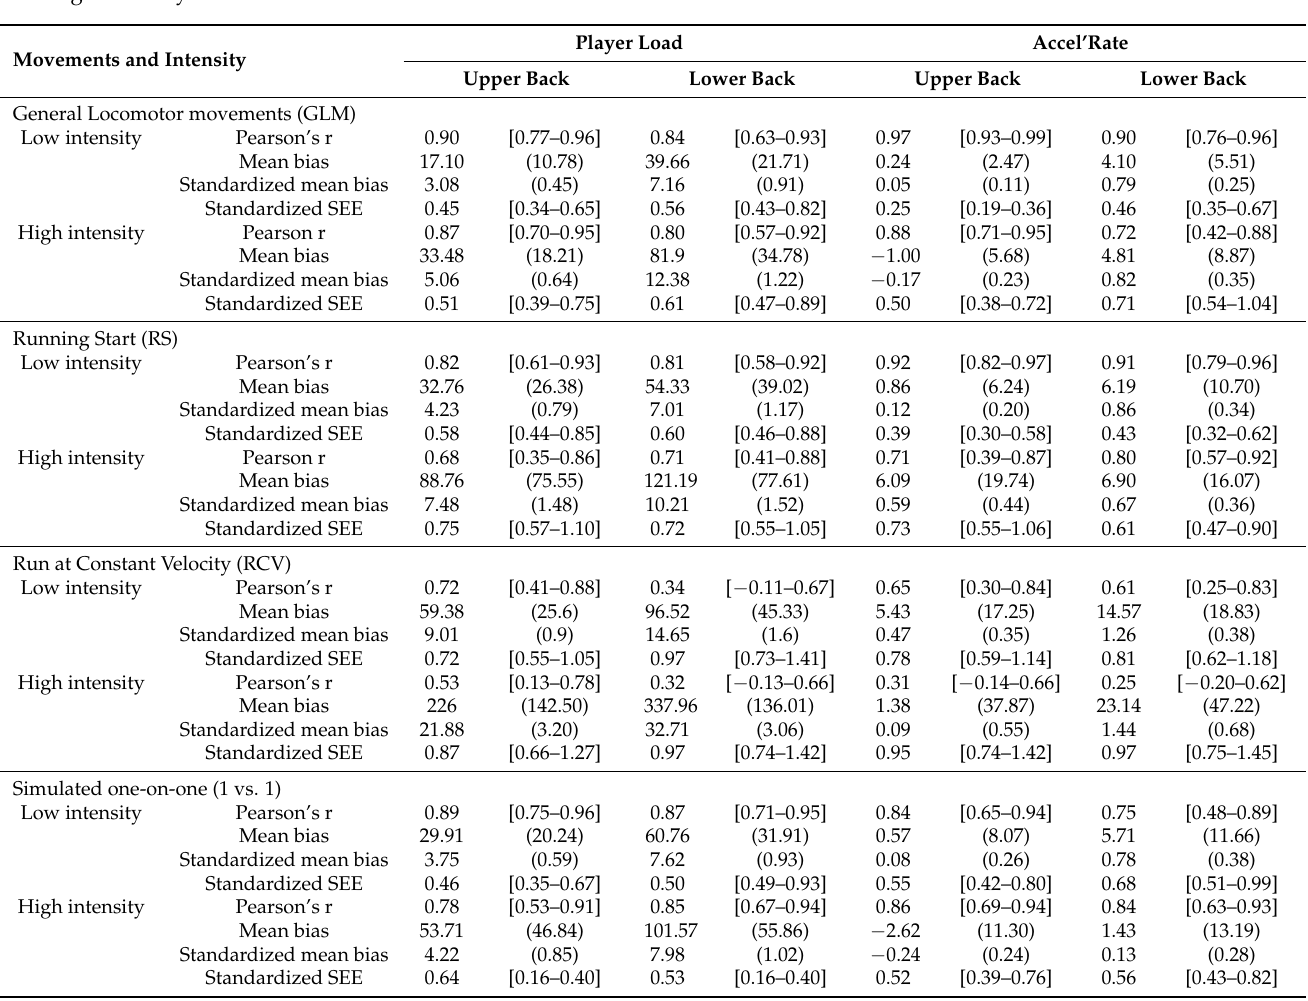
Table 1. Concurrent validity of the Player Load and the Accel’Rate measured with the triaxial accelerometers at the upper back and lower back positions and compared to the force plates gold standard method. Mean bias (in arbitrary units, a.u.) and standardized mean bias [ ± limits of agreements, LoA], Pearson correlation coefficient and standard error of estimate standardized (SEE) [confidence interval, 95% CI] were calculated for the 4-tested running-based locomotor task, at low and high